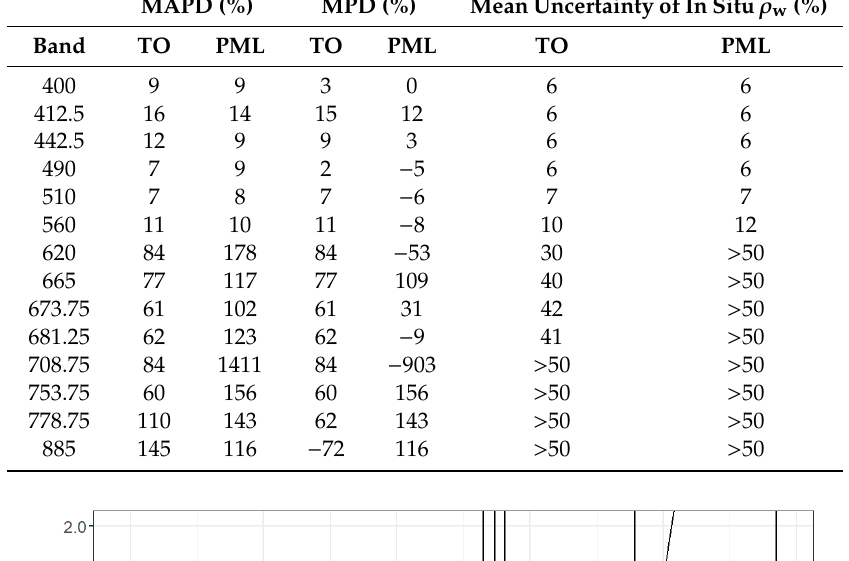
Table 3. The Mean Absolute Percentage Di ff erence (MAPD) and Mean Percentage Di ff erence (MPD) as calculated between Ocean Land Colour Instrument (OLCI) and in situ ρ w data measured by TO or PML over five match-up stations. Straylight and NIR similarity correction was applied to in situ data. The mean in situ uncertainty for both radiometers is shown in the right column.